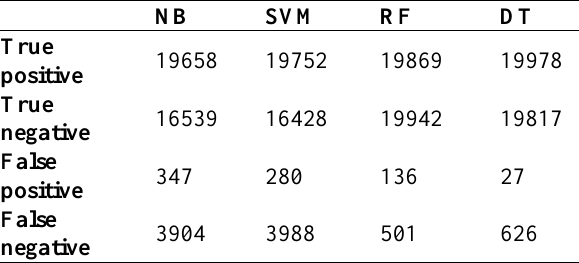
Table 10. Experiment with 27 Attributes.